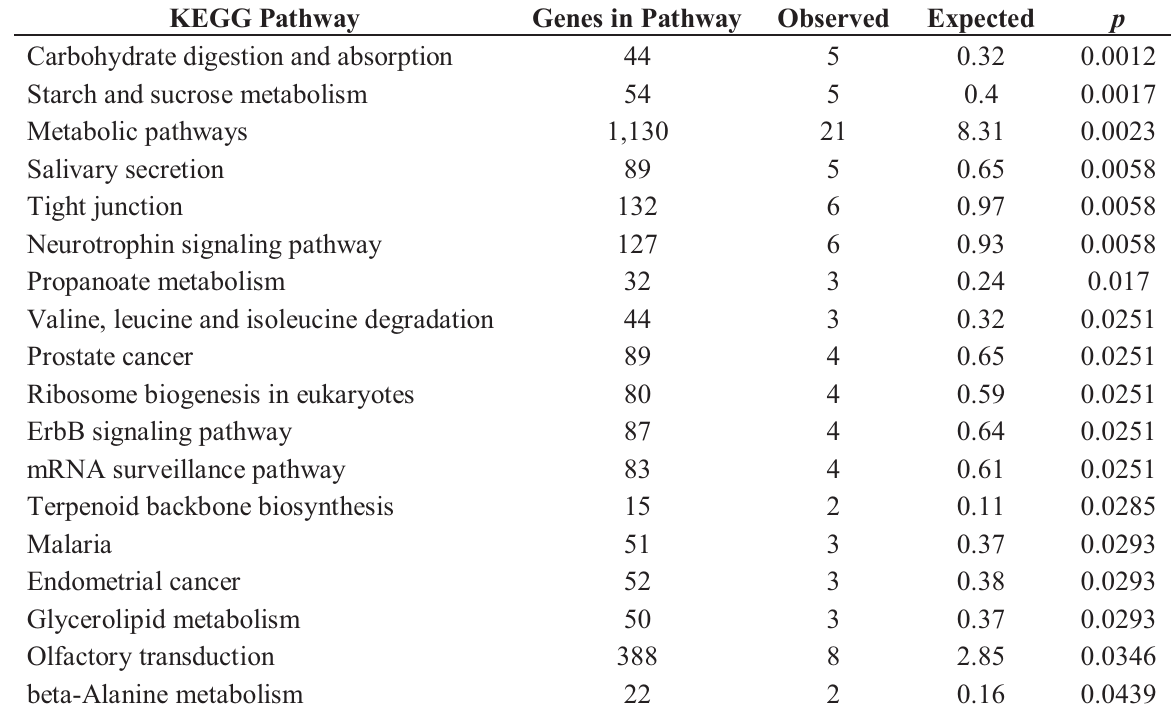
Table 5. Enriched Kyoto Encyclopedia of Genes and Genomes (KEGG) pathways from genes identified from CNVs unique to